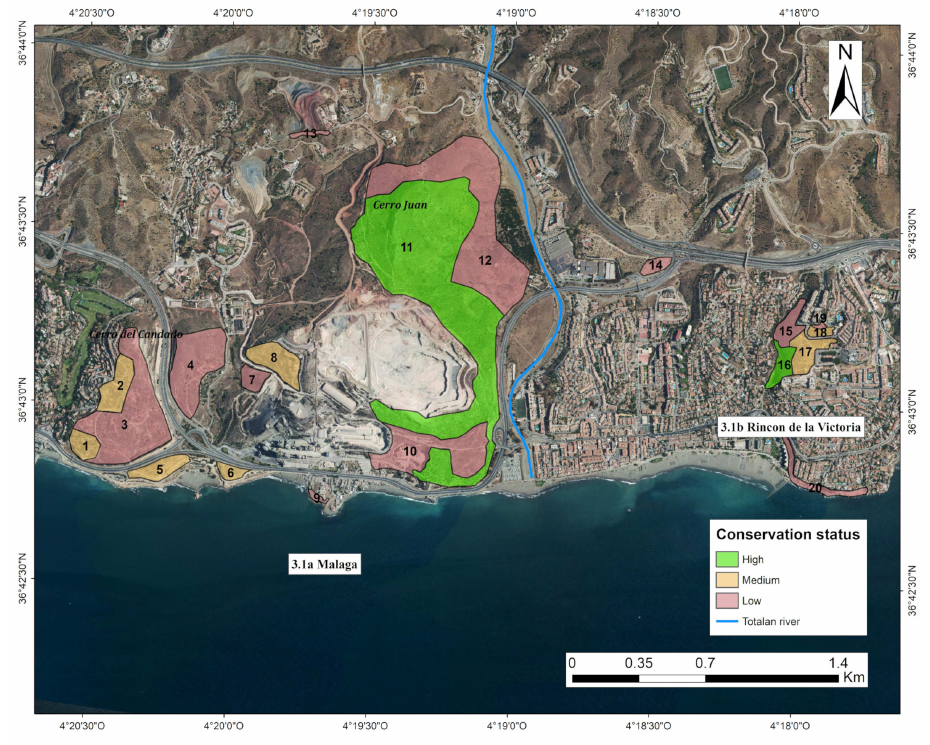
Figure 4. M á laga–Rinc ó n de la Victoria locality cartography. The color indicates the degree of conservation (DC) of the 5220* HCI at each polygon number: the green color indicates a high DC; the orange color means a good DC; and the red color corresponds with a reduced DC. The base map used is the World Imagery, provided by ESRI [52]: layer services credits source: Esri, Maxar, GeoEye, Earthstar Geographics, CNES/Airbus DS, USDA, USGS, AeroGRID, IGN, and the GIS User